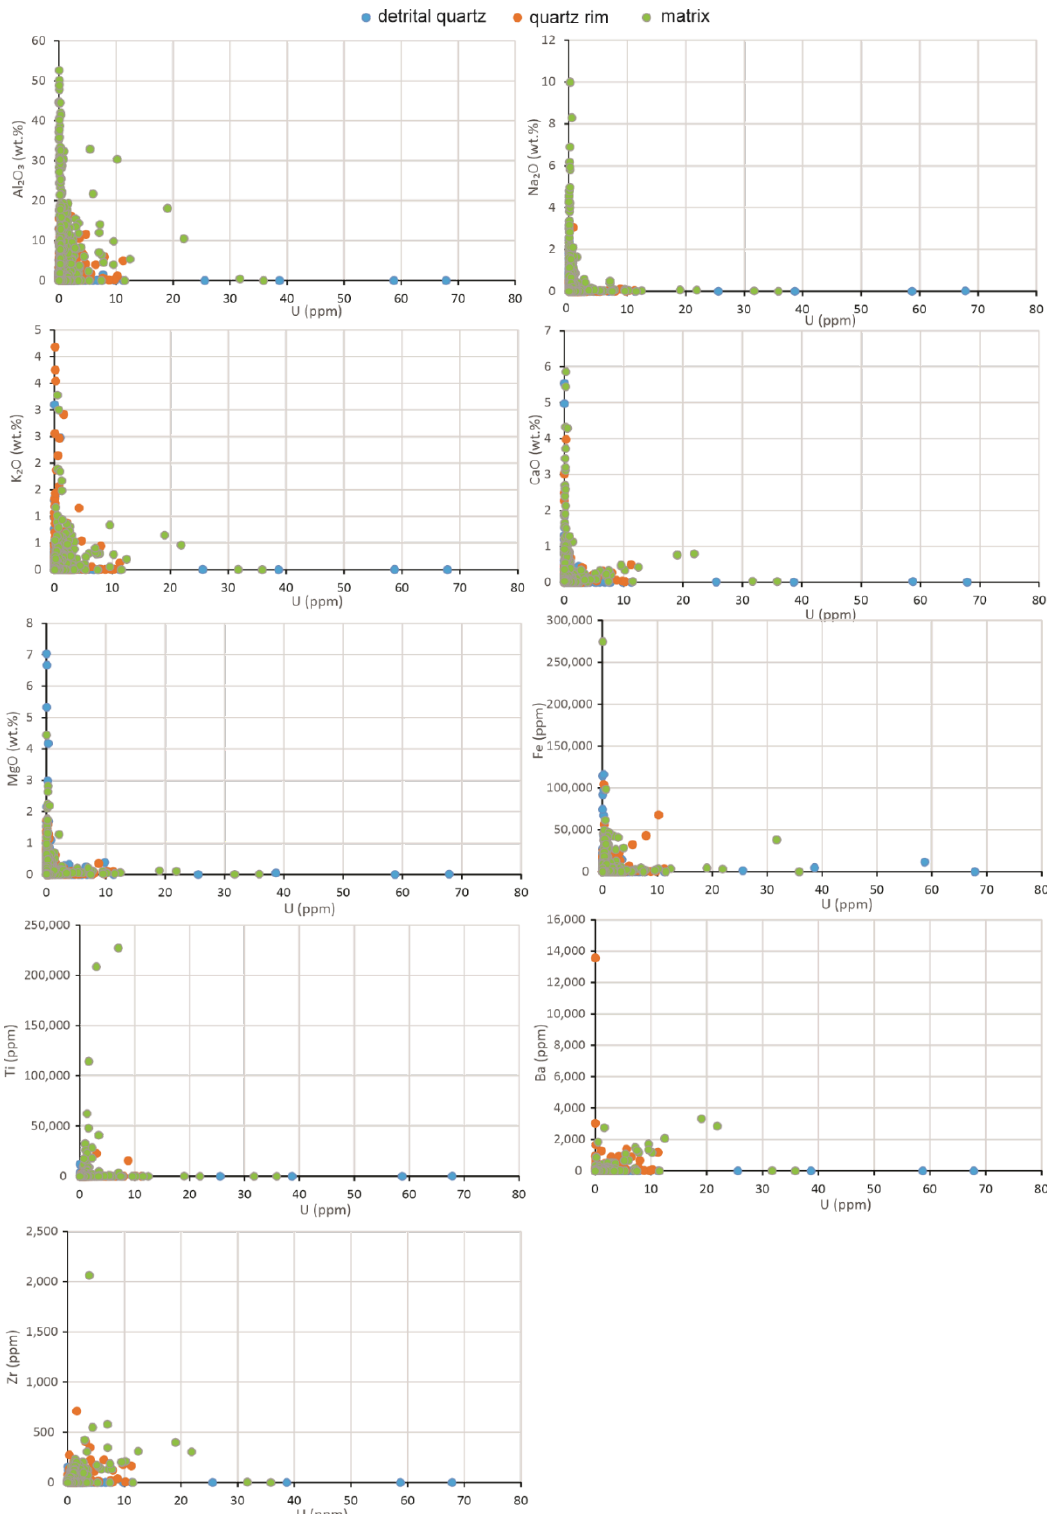
Figure 5. Bivariate diagrams showing strong positive correlations between U and La, Y, Th, Sr and P, in both linear ( left column ) and log ( right column ) scales. However, note the low concentrations of these elements for the few spots that contain the highest U (>25 ppm).